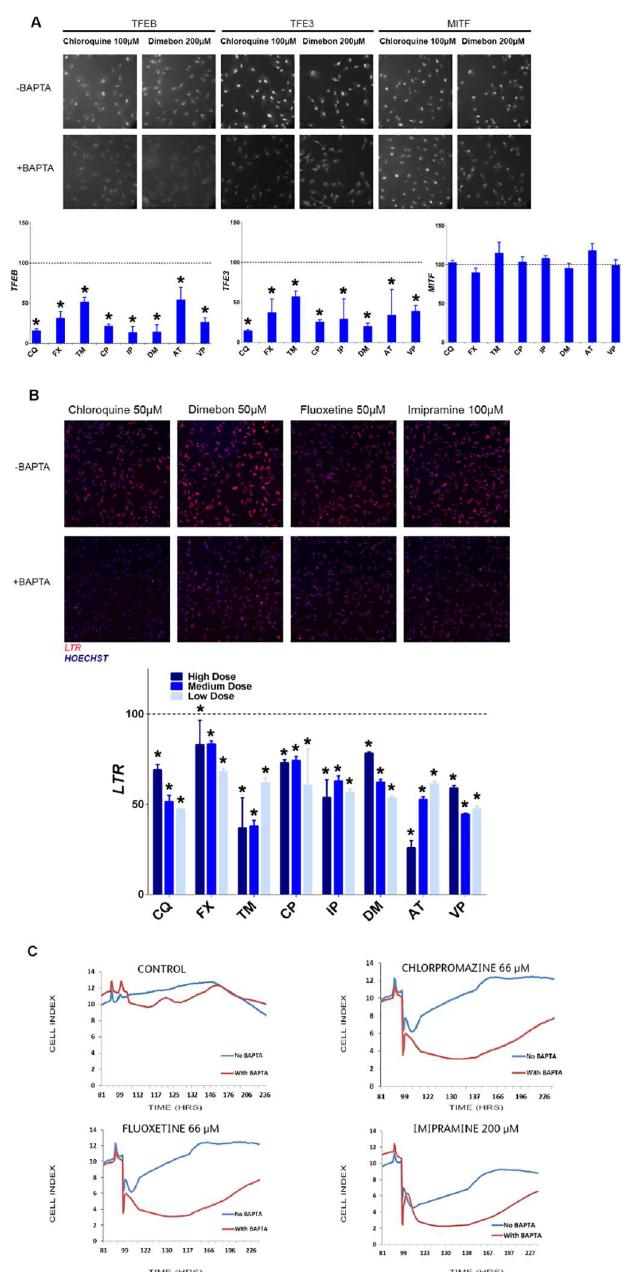
Fig 6. Involvement of calcium in the nuclear translocation of TFEB, TFE3 and MITF, and lysosomal activation. Representative images for nucleartranslocation of TFEB, TFE3 and MITF (A) and LTR staining (B) with and without BAPTA co-treatment. The graphs representthe percentageof total signal intensity with BAPTA co-treatment comparedto corresponding drug treatment alone (mean ± SD), * p (cid:20) 0.05. Kinetic cytotoxicity profile with and without BAPTA co-treatment (C). Tested drugs includechloroquine(CQ), fluoxetine(FX), imipramine (IP), dimebon(DM), tamoxifen (TM), chloropromazine (CP), amitriptyline (AT), and verapamil